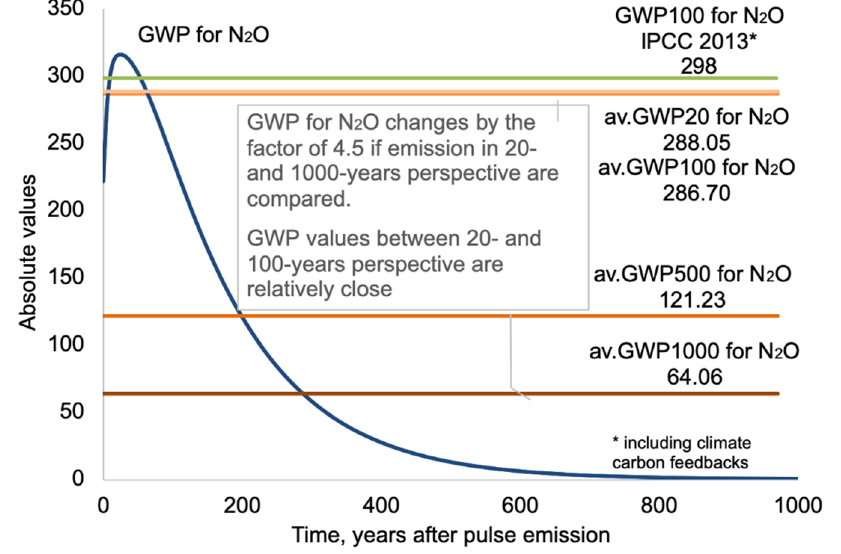
Figure 11. Absolute GWP values for N 2 O emissions given using the BCCM “GWP for N 2 O” and average GWP values for the first 20 years after pulse emission of N 2 O named “av.GWP20 for N 2 O” and has the value of 288.05; for the first 100 years—“av.GWP100 for N 2 O”; for the first 500 and 1000 years—“av.GWP500 for N 2 O” and “av.GWP1000 for N 2 O”. GWP value for the first 100 years given in the IPCC 2013, including the carbon cycle feedback, has the value of 298 and is given as “GWP100 for N 2 O IPCC 2013*”, unitless.